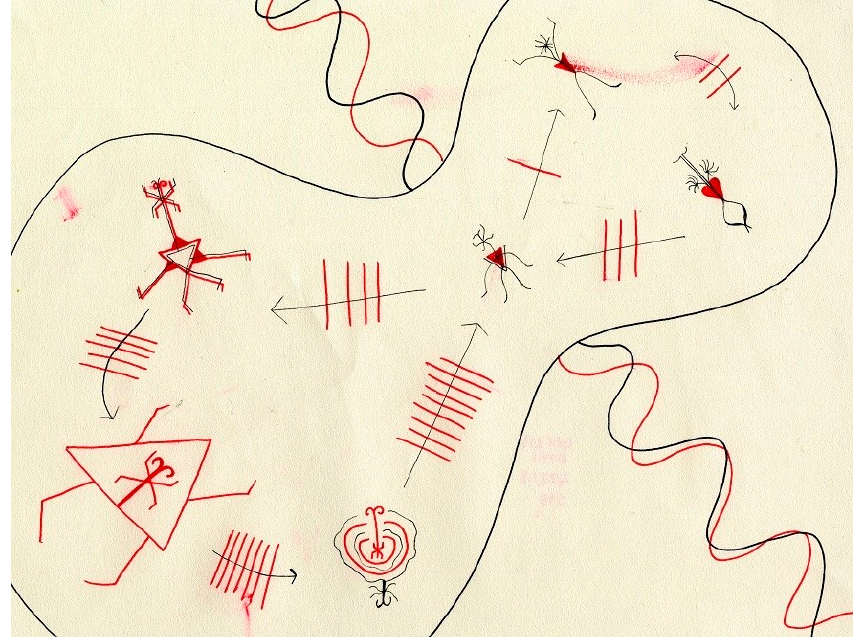
Figure A8. “Figure 8”. Red and black pen, white paper. Drawing made by authors. License: Creative Commons Attribution-NonCommercial 4.0 International.